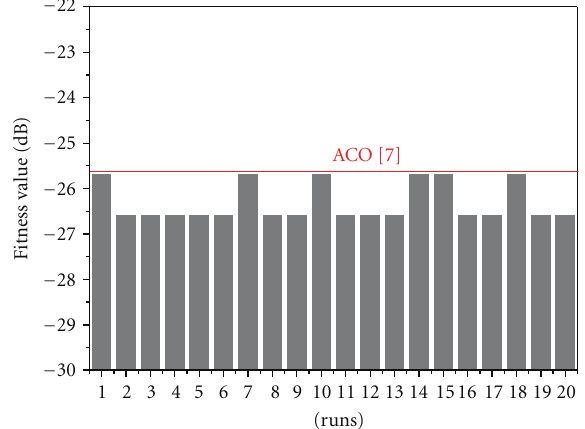
Figure 5: Radiation patterns in ϕ = 0 ◦ , ϕ = 45 ◦ and ϕ = 90 ◦ planes.